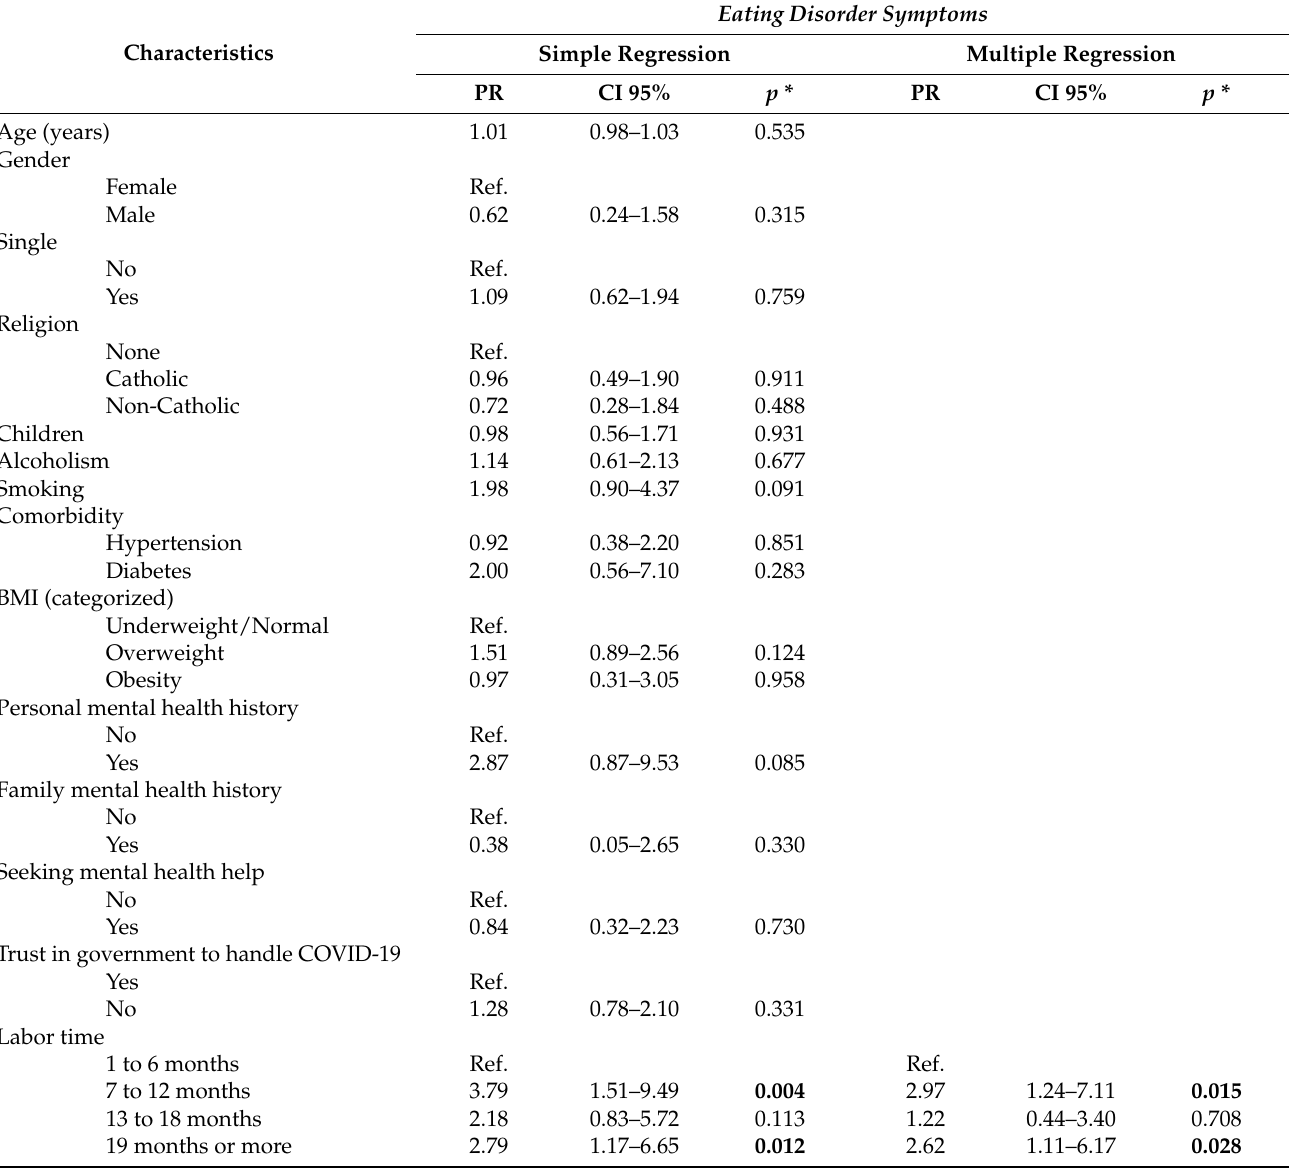
Table 3. Factors associated with eating disorder symptoms in military first line of defense against COVID-19 in Lambayeque, Peru in simple and multiple regression